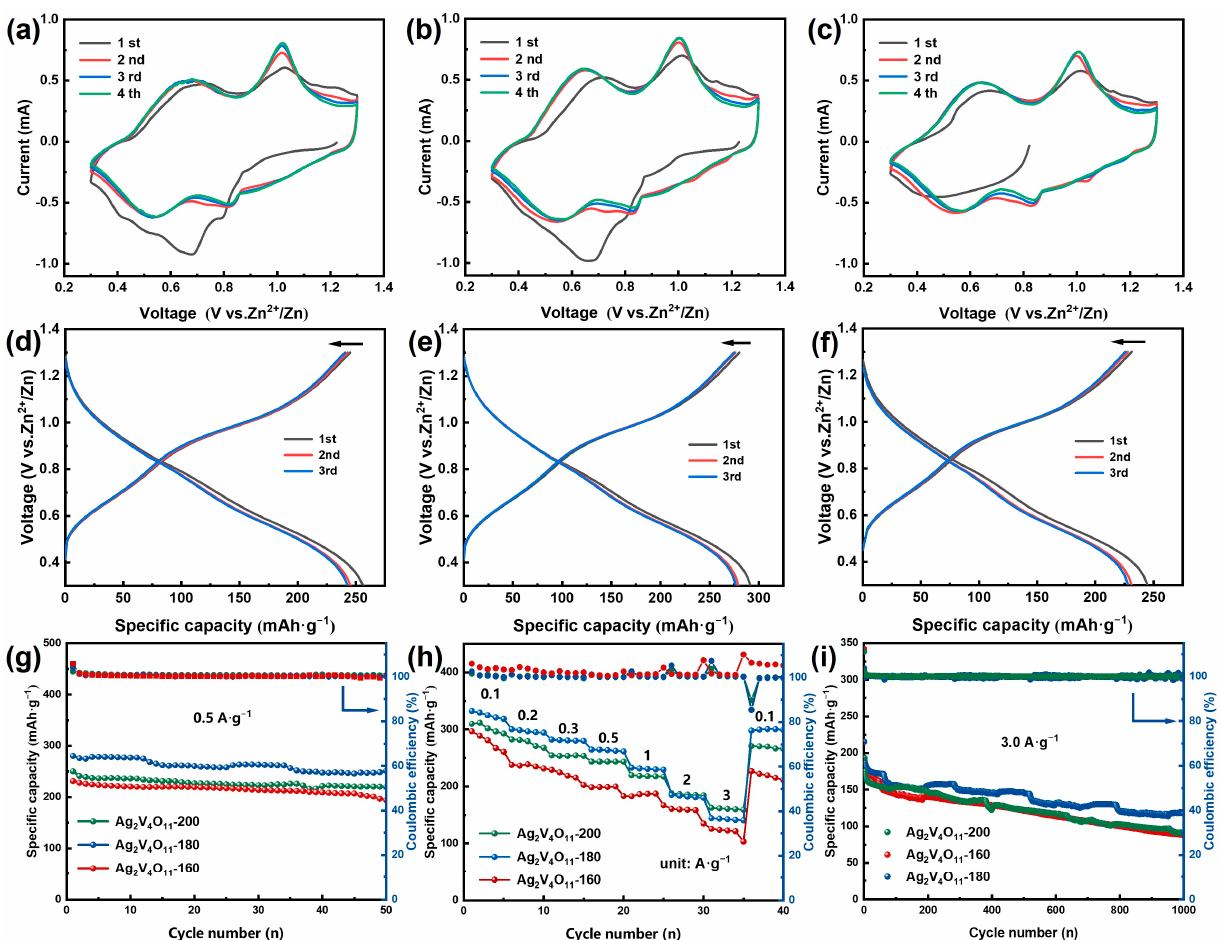
Figure 3. CV curves of ( a ) Ag 2 V 4 O 11 -200, ( b ) Ag 2 V 4 O 11 -180 and ( c ) Ag 2 V 4 O 11 -160 at 0.1 mV · s − 1 ; charge-discharge profiles of ( d ) Ag 2 V 4 O 11 -200, ( e ) Ag 2 V 4 O 11 -180 and ( f ) Ag 2 V 4 O 11 -160 during the first three cycles; ( g ) Cycle performance at 0.5 A · g − 1 , ( h ) rate performance and ( i ) long-term cycle stability at 3 A · g − 1 of Ag 2 V 4 O 11 -160, Ag 2 V 4 O 11 -180 and Ag 2 V 4 O 11 -200,